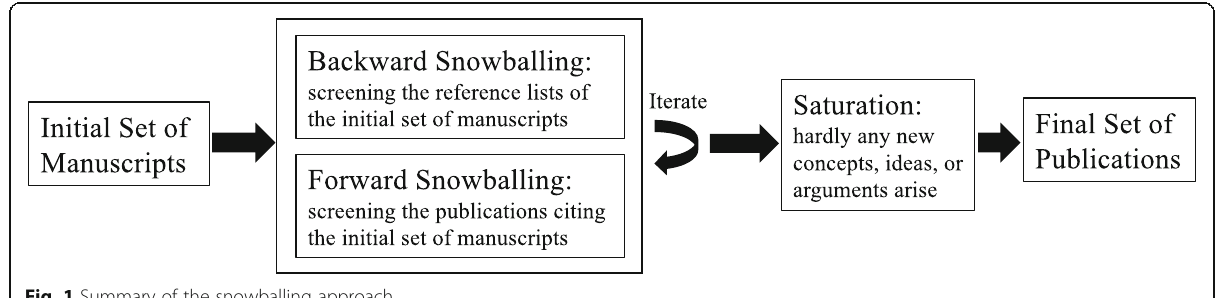
Fig. 1 Summary of the snowballing approach